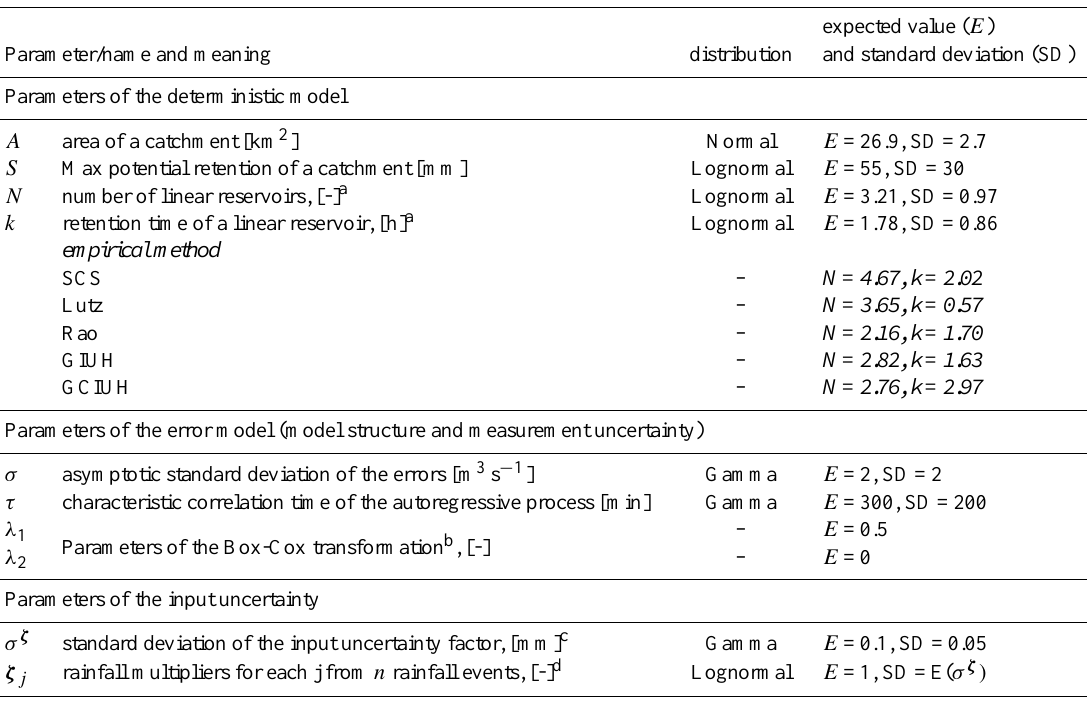
Table 2. Delivered prior distributions of model parameters.